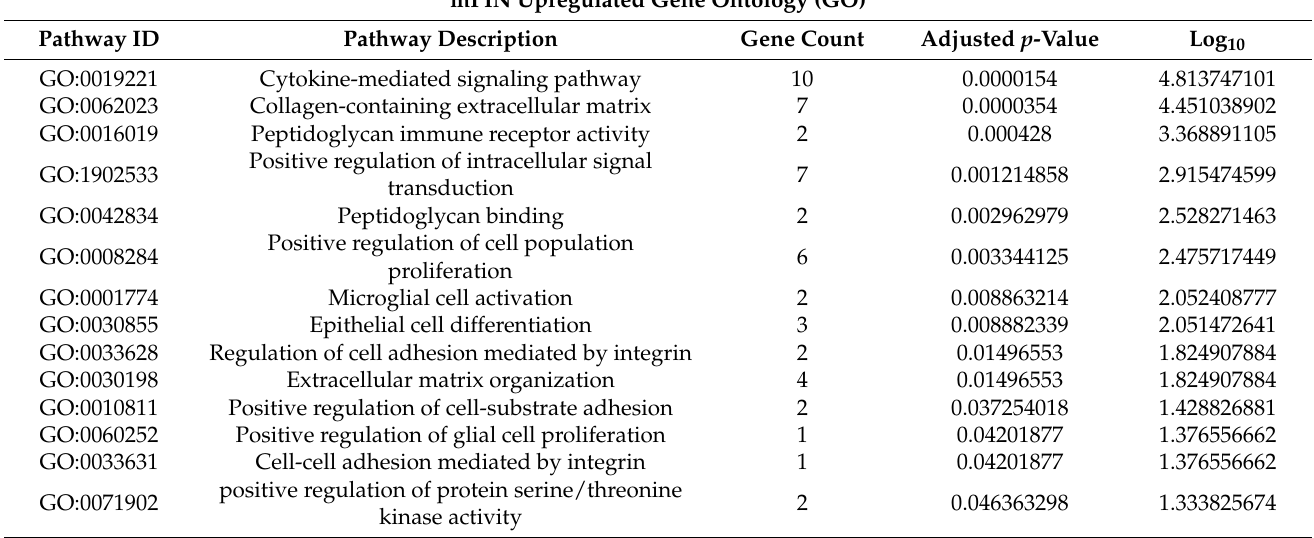
Table 2. A gene ontology (GO) enrichment analysis of secreted proteins upregulated in mPIN, MT, and AT of prostate